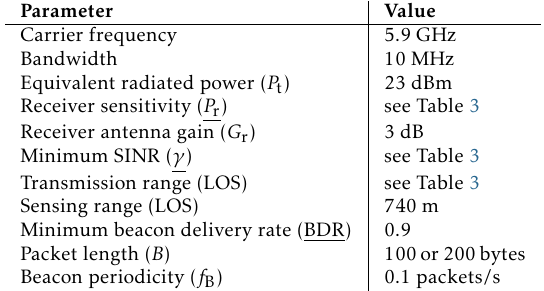
Table 2. Main simulation